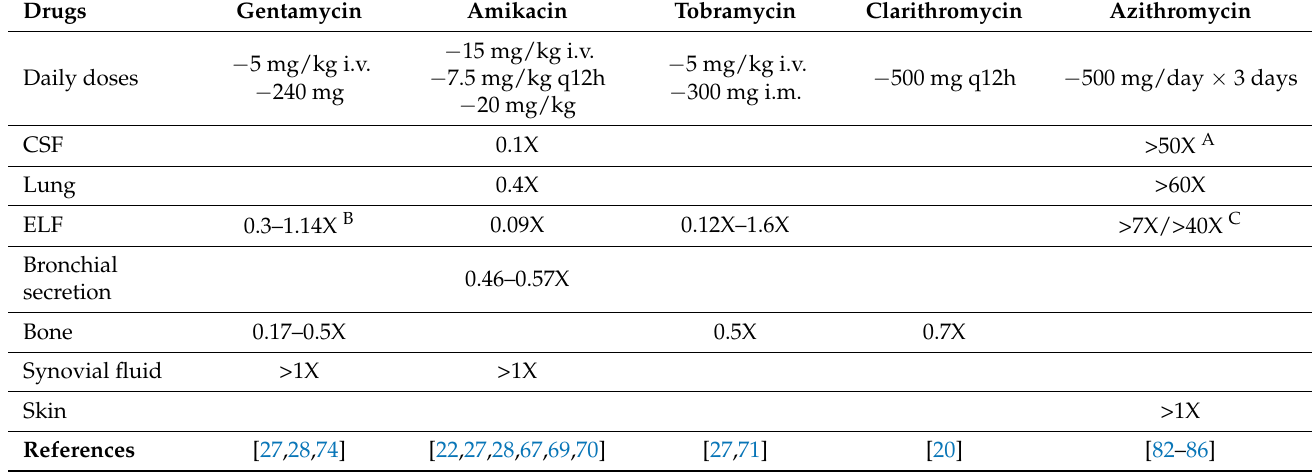
Table 2. The tissue/plasma ratio values for aminoglycosides, clarithromycin, and azithromycin. For each drug, the different daily doses that were administered to ICU patients are listed in the